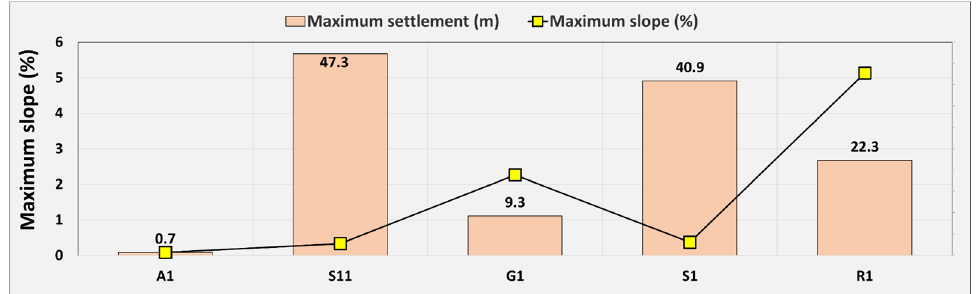
Figure 15. Settlement analysis for different tailings material types.